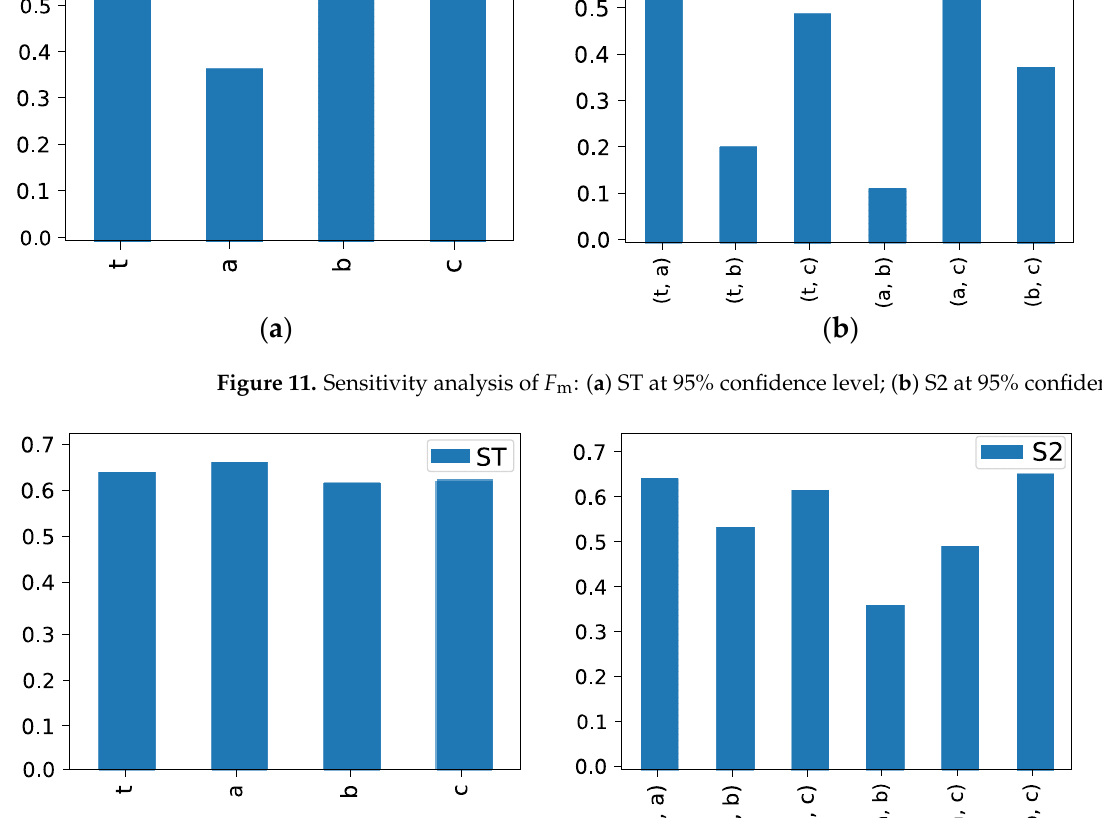
Figure 11. Sensitivity analysis of F m : ( a ) ST at 95% confidence level; ( b ) S2 at 95% confidence level.